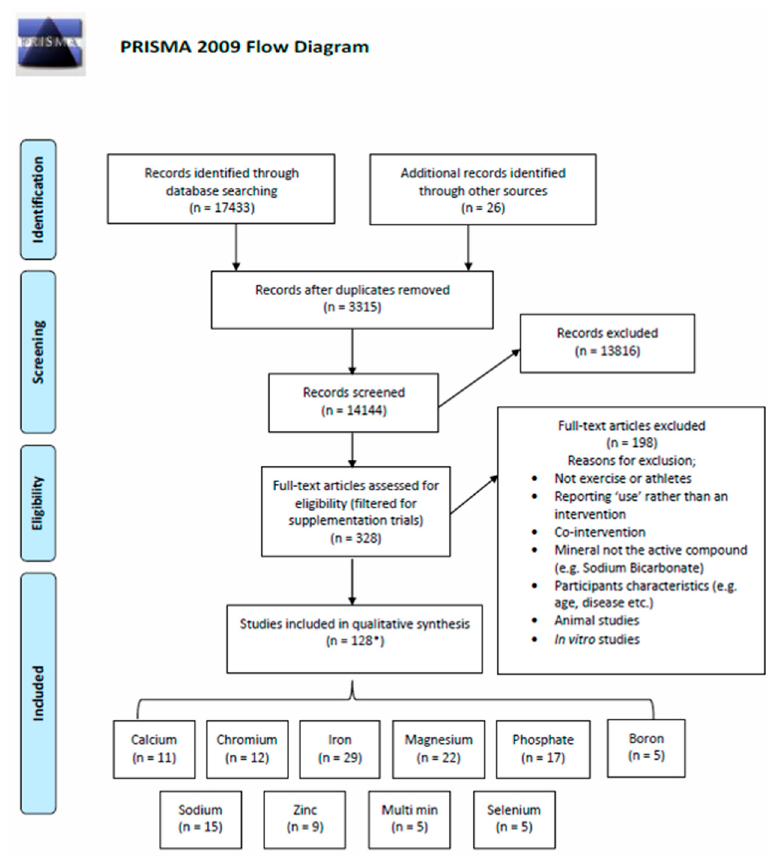
Figure 1. PRISMA schematic summarising the search strategy and study selection. * One study assessed both Zn and Se separately and in combination ( n = 3 groups). Thus, is counted in subsections Zn, Se and multi-minerals (also accounted for in all other cumulative study sample calculations).